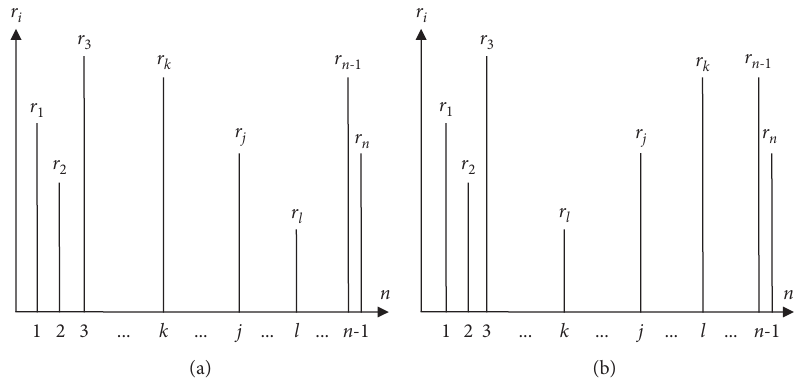
Figure 2: (a, b) Permutations of the initial set of